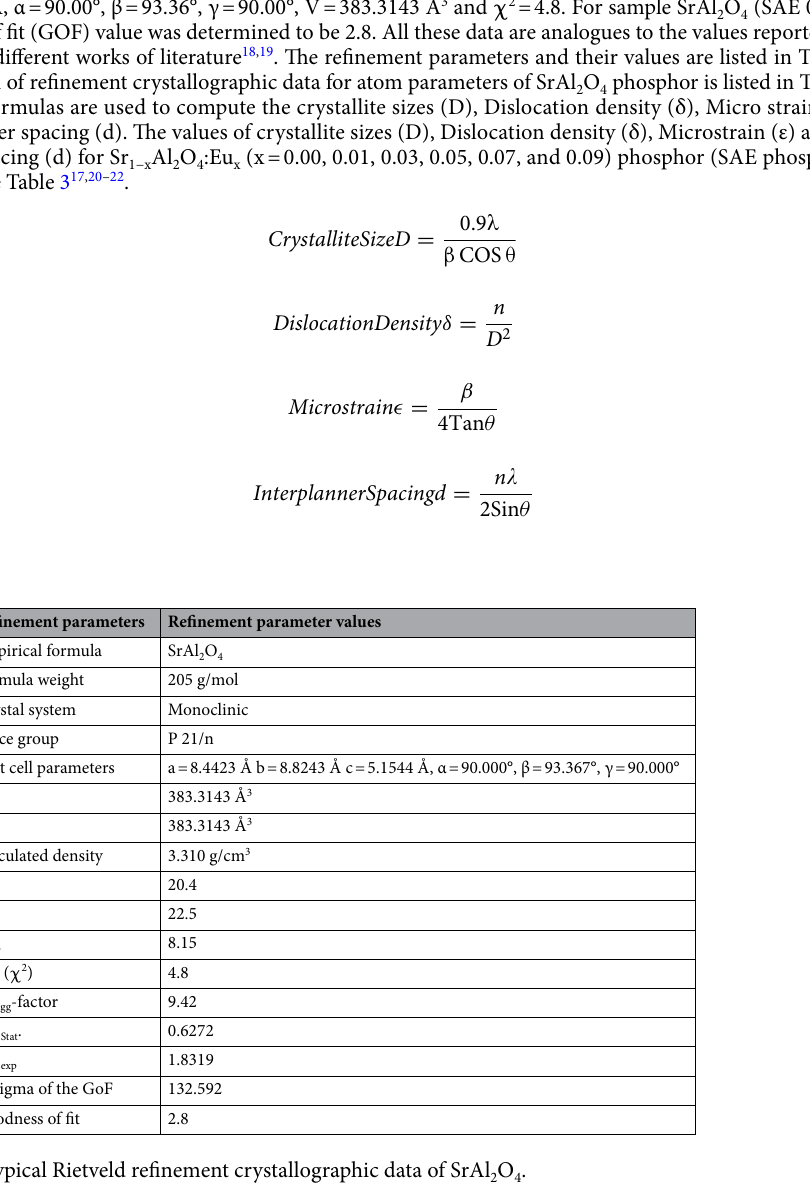
Table 1. Typical Rietveld refinement crystallographic data of SrAl 2 O 4 .